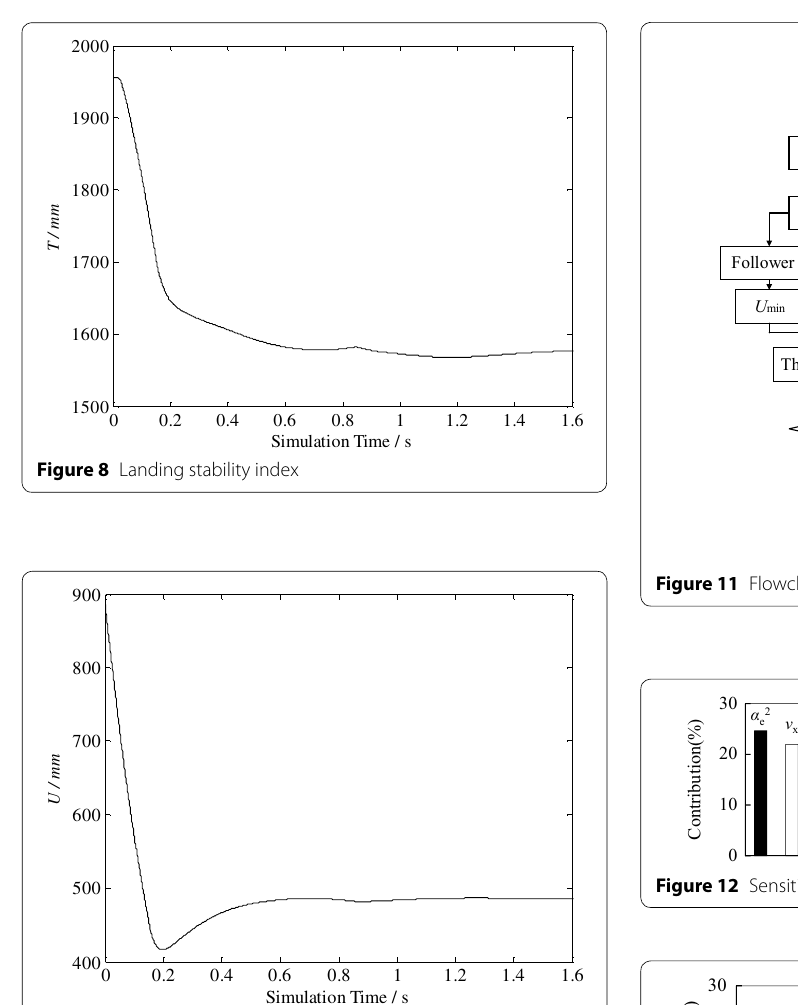
Figure 9 Nozzle’s performance against damage